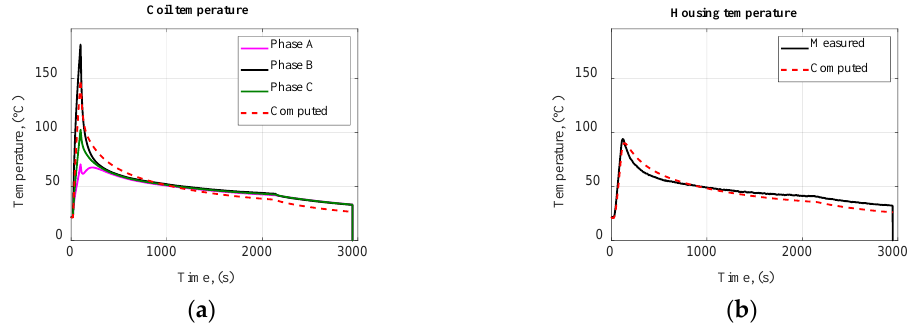
Figure 11. Measured and computed temperatures in the three phases ( a ) and in the housing ( b ) for the short-time pulse test in configuration B.